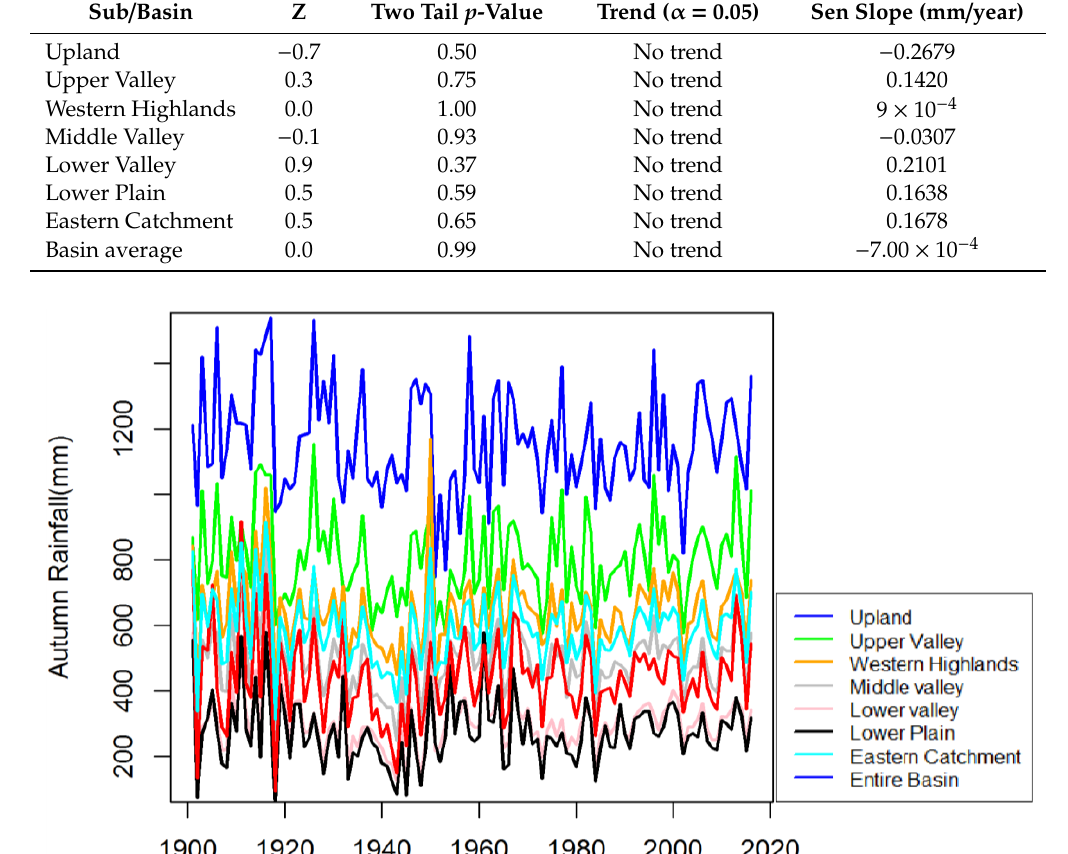
Figure 7. Annual rainfall time series for the sub-basins for the period 1900 – 2016.